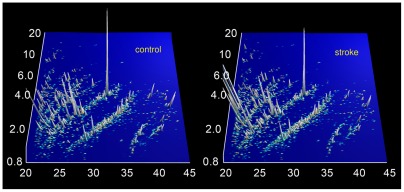
Urinary polypeptide signatures in cases and controls.Normalized molecular weight (800–20 000 Da) in logarithmic scale is plotted against normalized migration time (18–45 minutes). The mean signal intensity of the polypeptide peak is given in 3-dimensional depiction. n = 26 controls and 33 cases.